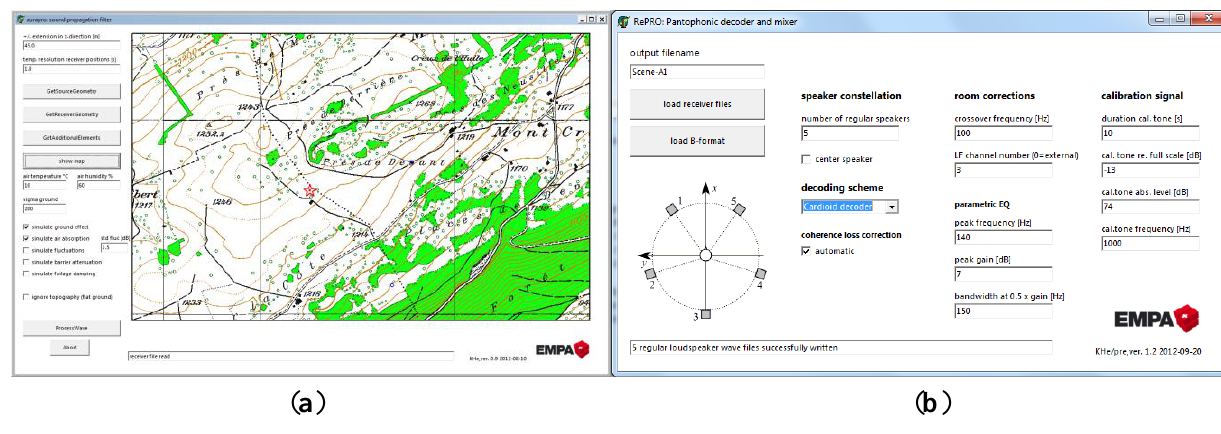
Figure 5. Graphical user interfaces of the computer programs ( a ) AuraPRO and ( b )